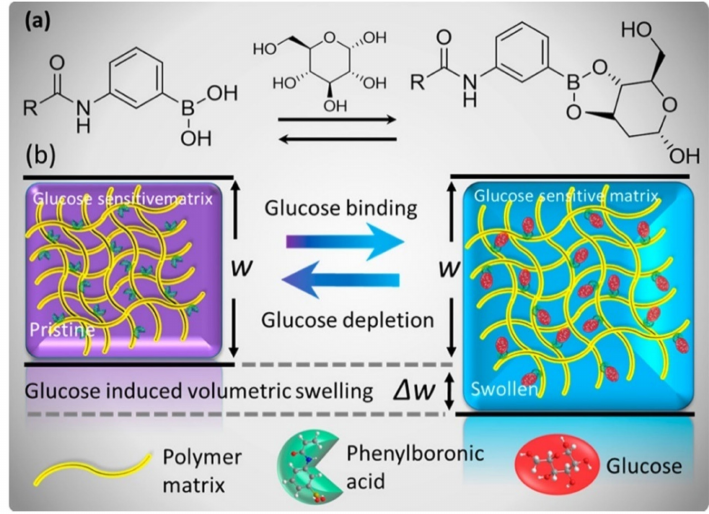
Figure 10. ( a ) Illustration of the binding process of glucose with the boronic acid portion, causing the swelling of the hydrogel matrix. ( b ) Illustration of the volumetric transition of the hydrogel when glucose is introduced or depleted in the matrix. Reprinted with permission from reference [103]. Copyright 2018 American Chemical Society.